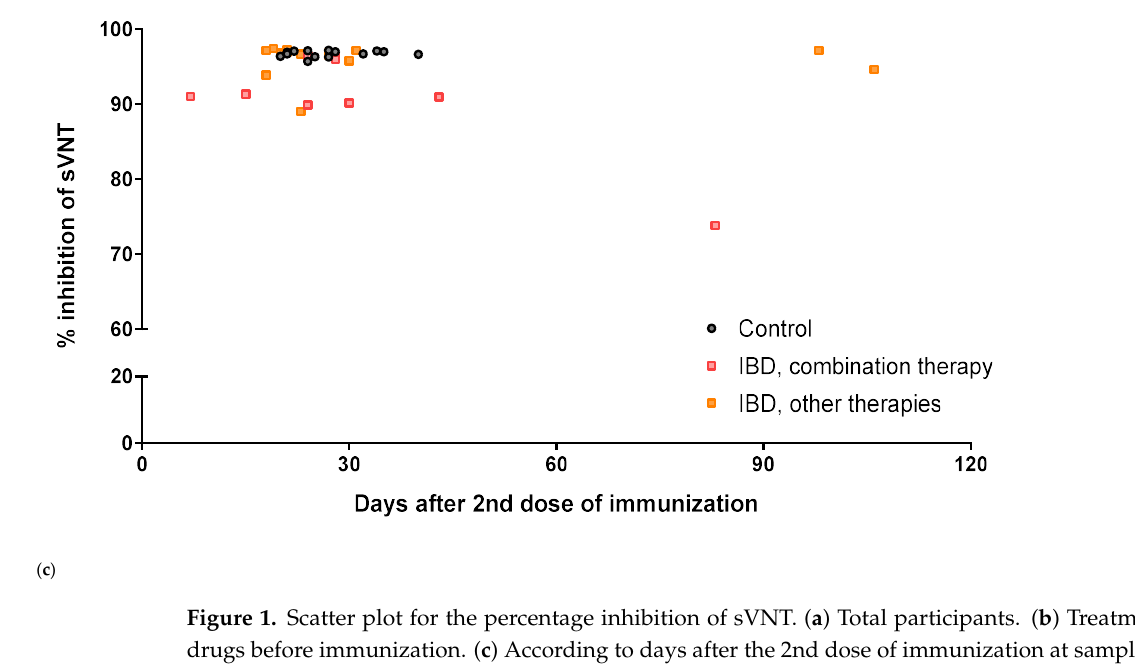
Figure 1. Scatter plot for the percentage inhibition of sVNT. ( a ) Total participants. ( b ) Treatment drugs before immunization. ( c ) According to days after the 2nd dose of immunization at sampling. * indicates p = Each dot represents the level of percentage inhibition in each subject’s serum. Horizontal bars indicate the median and interquartile ranges. sVNT, surrogate virus neutralization test; IBDs, in- flammatory bowel diseases; 5-ASA, 5-aminosalicylic acid.